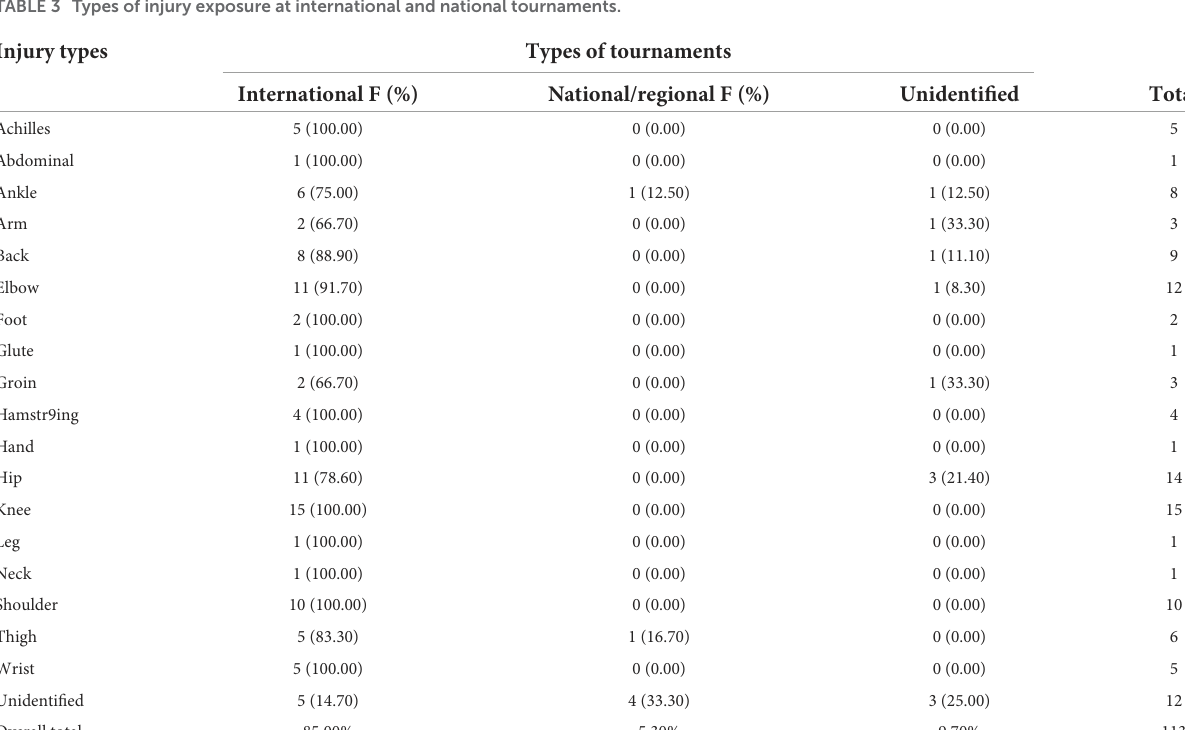
TABLE 3 Types of injury exposure at international and national